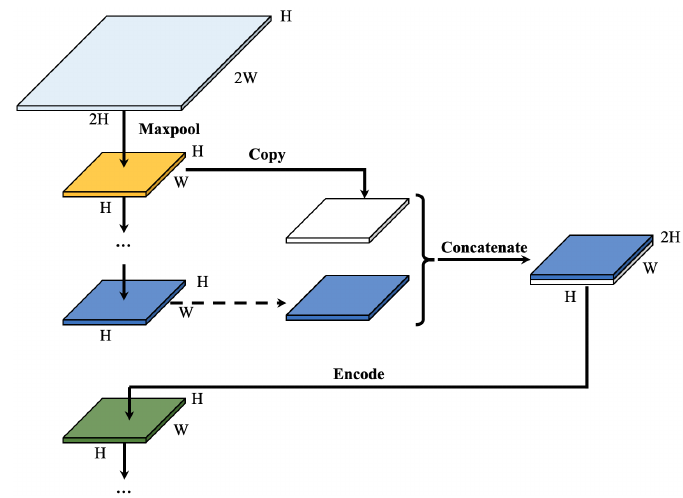
Figure 5. Example of copying and